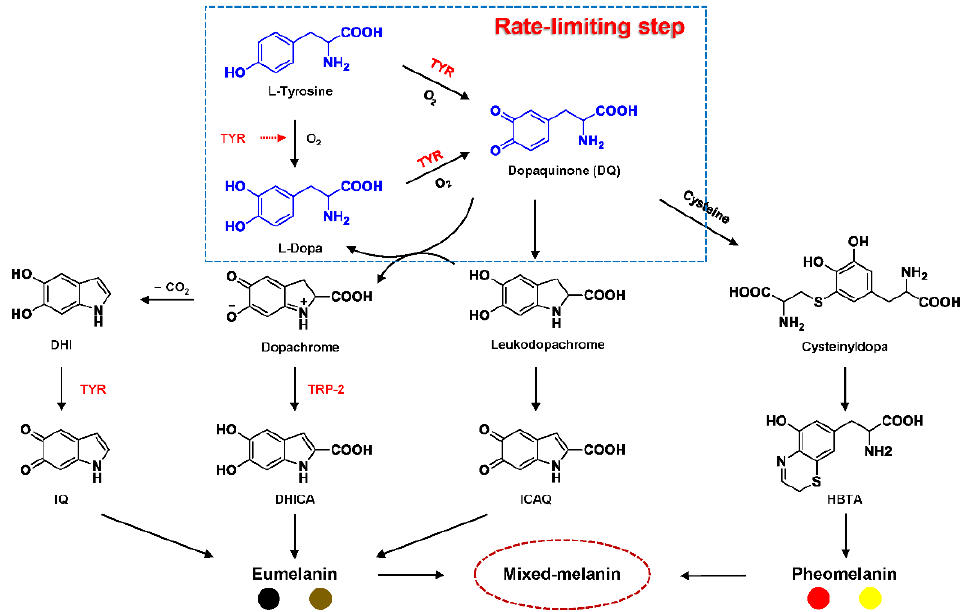
Figure 2. Biosynthetic pathway of melanin [7,8,10]. DQ: dopaquinone; L-Dopa: L-3,4-dihydroxyphenylalanine; DHICA: 5,6-dihydroxyindole-2 carboxylic acid; DHI: 5,6-dihydroxyindole; ICAQ: indole-2-carboxylic acid-5,6-quinone; IQ: indole-5,6-quinone; HBTA: 5-hydroxy-1,4-benzothiazinylalanine.